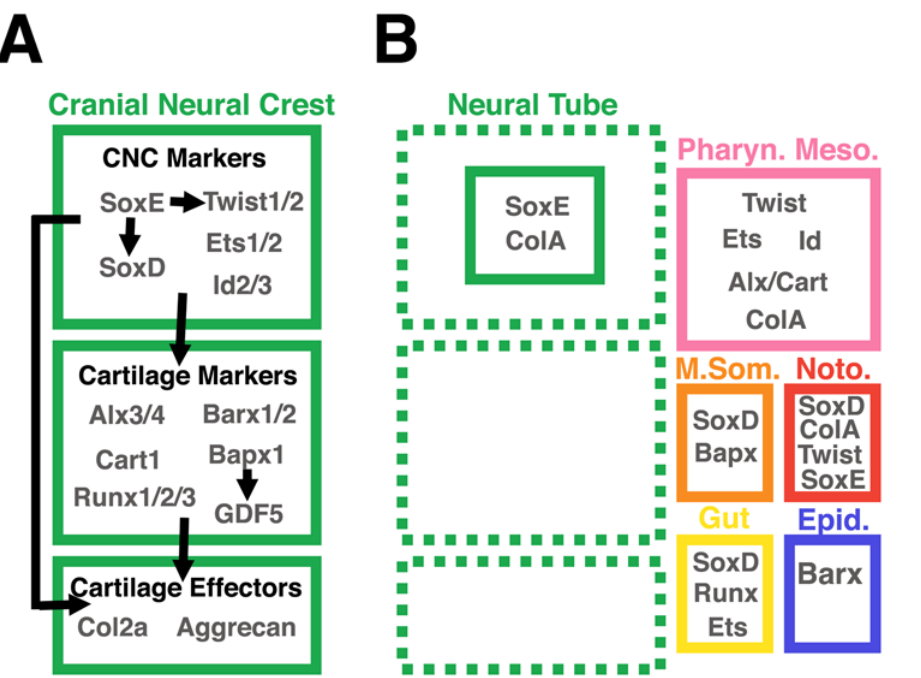
Figure 1. A provisional gene network operating in nascent neural crest-derived cartilage and expression of network component homologs in amphioxus. ( A ) We have classified genes in the network as cranial neural crest (CNC) markers, cartilage markers, or effector genes based on their expression, regulatory relationships, and biochemical functions. Among the CNC markers are Sox9 (SoxE), Sox5/6 (SoxD), Twist1/2 and Ets1/2 genes. All of these factors are expressed in post-migratory chondrogenic cranial neural crest [8,9,11,45,46]. SoxE , SoxD , and Twist1/2 have been shown to cross- regulate, and to activate cartilage specifiers and effector genes. SoxE is required for expression of both SoxD and Twist1/2 in migrating CNC [8,34], while Twist1/2 is necessary for the continued expression of SoxE in postmigratory CNC[9]. Both SoxE and SoxD cooperate to directly activate the definitive cartilage differentiation marker Col2a1 in chondroblasts[47], while Twist1/2 is required for expression of the aristalless -related transcription factors Alx3/4 and Cart1 [ 9 ]. Ets1/2 expression overlaps temporally and spatially with SoxE , SoxD and Twist1/2 , though functional relationships between it and the other network components have yet to be demonstrated [11]. In sea urchins, Ets1/2 and Alx3/4 orthologs are necessary for the formation of skeletogenic mesenchyme and are regulated by the same upstream factors, suggesting they cooperate in an evolutionarily ancient skeletogenic program [48,49]. As chondrogenesis begins, presumptive pharyngeal chondrocytes express genes grouped here as cartilage markers ( Barx1/2, Alx3/4, Cart1, Runx1/2/3, Bapx1 , and GDF5 ). These genes are expressed in differentiating CNC-derived chondrocytes [12–14,16,21,50–52], are downstream of CNC specfiers and upstream of effector genes like Col2a1 and Aggrecan, Barx1 physically interacts with Sox9 to directly activate Collagen2a1 expression [37]. As indicated above, Alx3/4 and Cart1 are regulated by Twist1/2 [ 9 ]. Runx1/2/3 expression in chondrocytes is dependent on SoxE function[16]. In the pharynx, Bapx1 functions mainly to position the jaw joint by regulating expression of GDF5 [ 21,53 ]. In the mesoderm-derived axial skeleton, however, Bapx1 is expressed broadly and operates upstream of Sox9, Col2a1 , and Runx1/2/3 [ 54,55 ]. Essential for maintenance and establishment of the chondrogenic subnetwork are signaling molecules of the FGF and Endothelin families which are secreted by surround pharyngeal endoderm and ectoderm[20,21] (not shown). These genes also mediate pharyngeal arch patterning by activating nested expression of various transcription factors in the nascent cartilages including Dlx and Msx genes, Gsc , and Hand2 [21,43](not shown). ( B ) The major expression domains of chondrogenic neural crest gene homologs in amphioxus neurulae and larvae. No single cell type expresses the complete set of vertebrate chondrogenic network genes, indicating the cranial neural crest cartilage program is a vertebrate novelty. Notably, most factors are expressed in mesodermal derivatives, suggesting neural crest-derived cartilage evolved via repeated cooption of primitively mesodermal